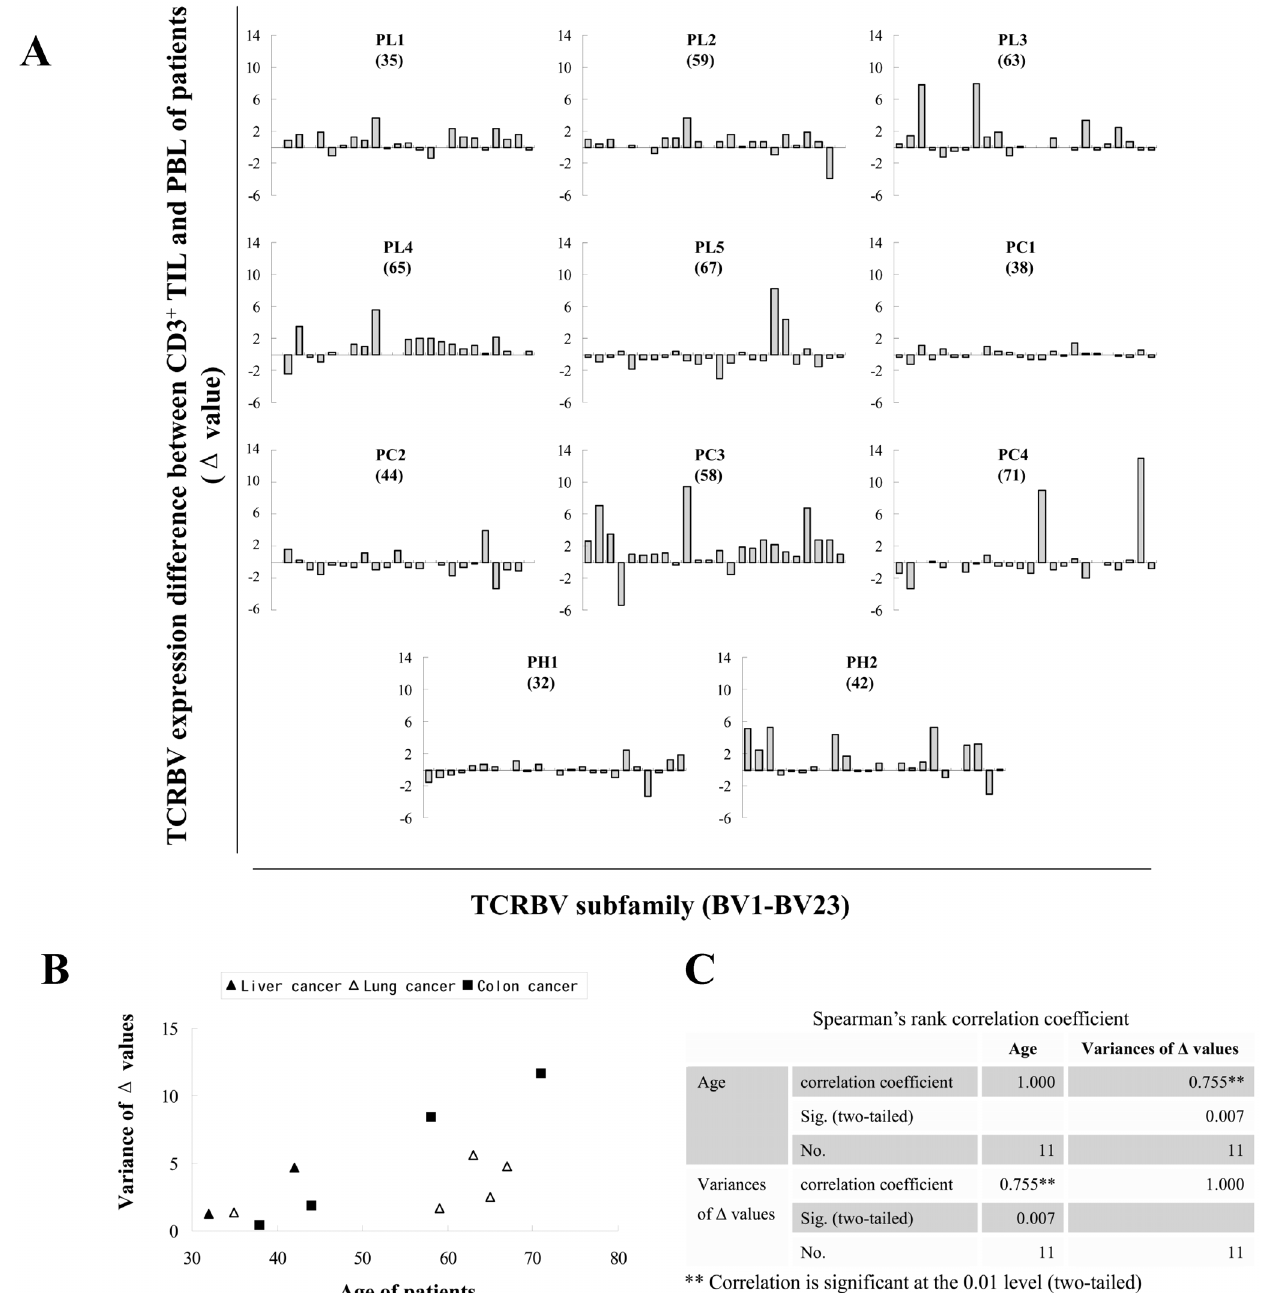
Figure 2. Analysis of expression difference of TCR-V b repertoire between TIL and PBL of cancer patients. ( A ) Expression difference of TCR-V b subfamily between TIL and PBL ( D value) is calculated as the percentage of each TCR-V b subfamily in CD3 + TIL minus the counterpart in CD3 + PBL. All 24 D values (for 24 TCR-V b subfamilies) were used to generate a histogram for each patient. The numbers in brackets are the ages of patients. ( B ) The dispersion degree of D values is expressed as variance. The variances were subsequently matched with the age of the patient to generate a scatter plot. ( C ) The linear correlation coefficient between variance and age was subsequently computed by SPSS software with Spearman’s rank- order correlation model. doi:10.1371/journal.pone.0102327.g002 able overexpression by FCM detection, did display an oligoclonal/ Decreased ratio of CD8 + CD62L + cells in TIL to that in PBL monoclonal expansion pattern in 3 out of 5 TIL specimens (Fig. 4). with age Immunoscope analysis indicated that, although oligoclonal/ The loss of surface L-selectin (CD62L) expression can be used to monoclonal expansion patterns appeared to increase with age, distinguish effector T cells (T E ) and effector memory T cells (T EM ) many TCR-V b subfamilies overexpressed in TIL specimens from both naive T cells and central memory T cells (T CM ) [28,29]. showed a polyclonal expansion pattern.